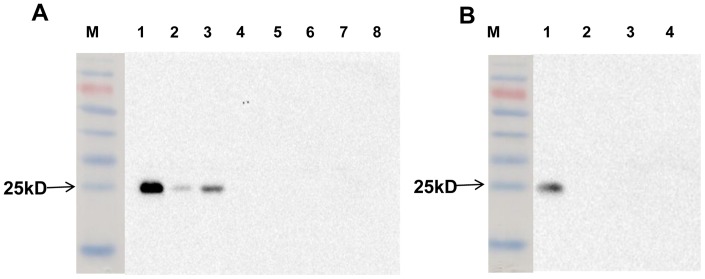
Western blot analysis to detect the specific MPB83 monoclonal antibody.(A) M, prestain marker; Lane 1, M. bovis; Lane 2, M. tb1458; Lane 3, H37Rv; Lane 4, M.graminis; Lane 5, M. avium; Lane 6, M. intracellulare; Lane7, M. smegmatisc; and Lane 8, MDBK cells. (B) M, prestain marker; Lane 1, H37Rv; Lane 2, M. paratuberculosis; Lane 3, E.coli from bovine origin; and Lane 4, Salmonella from bovine origin. The arrows indicate the MPB 83 protein.